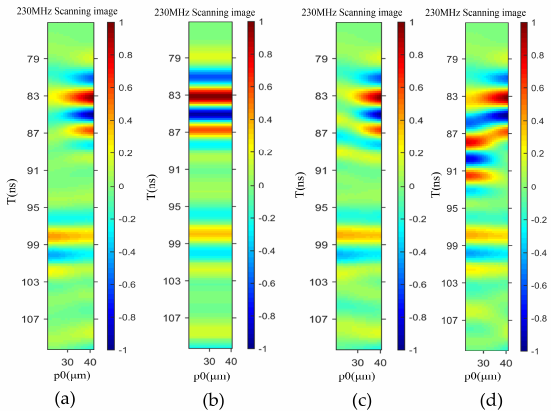
Figure 5. B-scan image of solder ball defects within 75–110 ns (( a ) defect-free, ( b ) ball missing, ( c ) void, ( d ) crack).